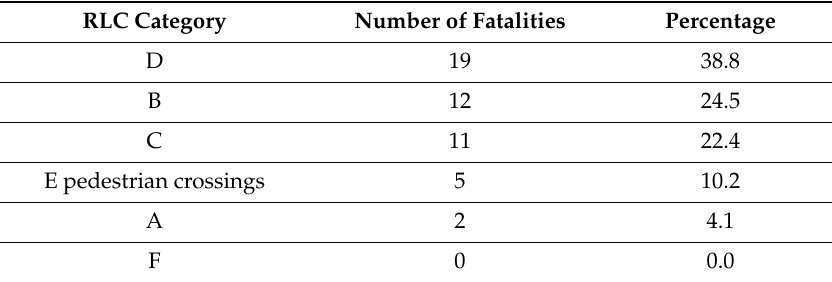
Table 4. RLCs with